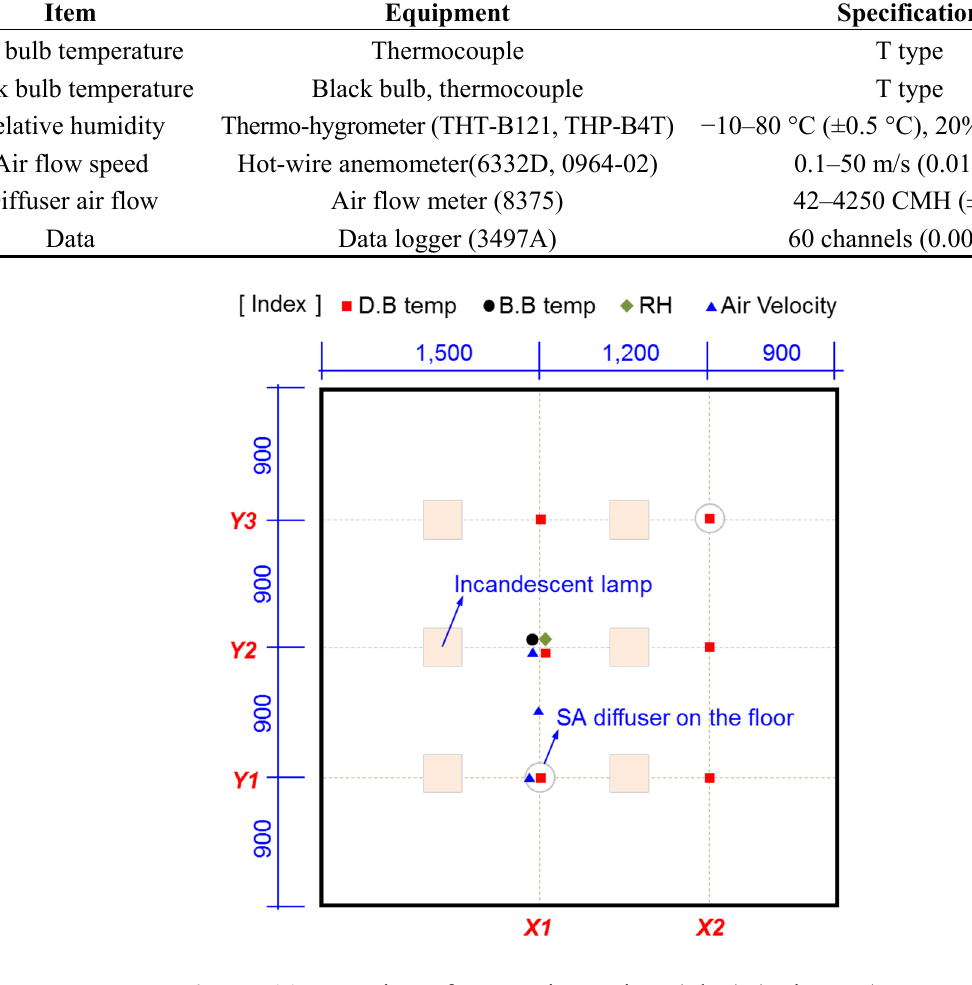
Figure 11. Location of measuring points (plan) (unit: